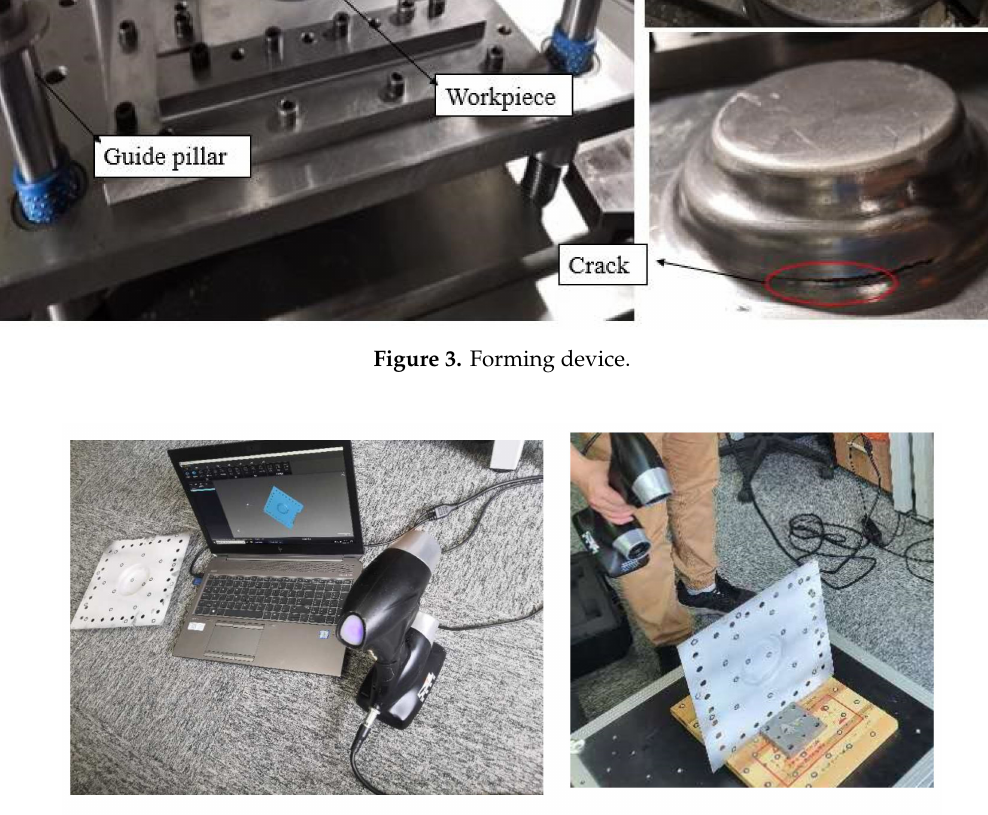
Figure 4. Scanning process and equipment: ( a ) measurement device and ( b ) scanning